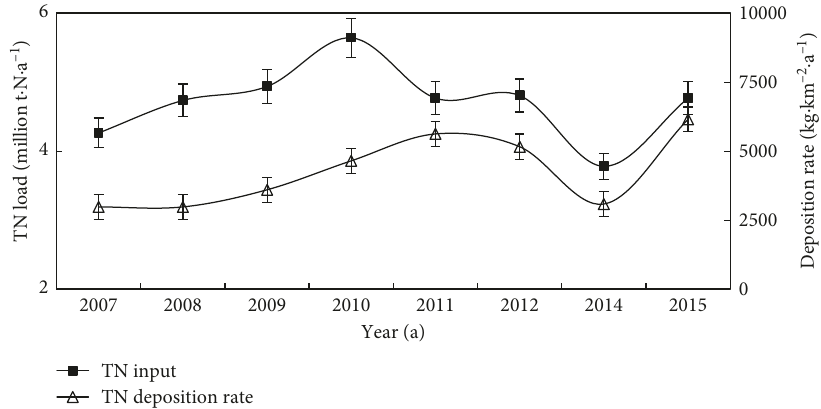
Figure 8: TN input into the lake and TN deposition rate in Taihu watershed from 2007 to